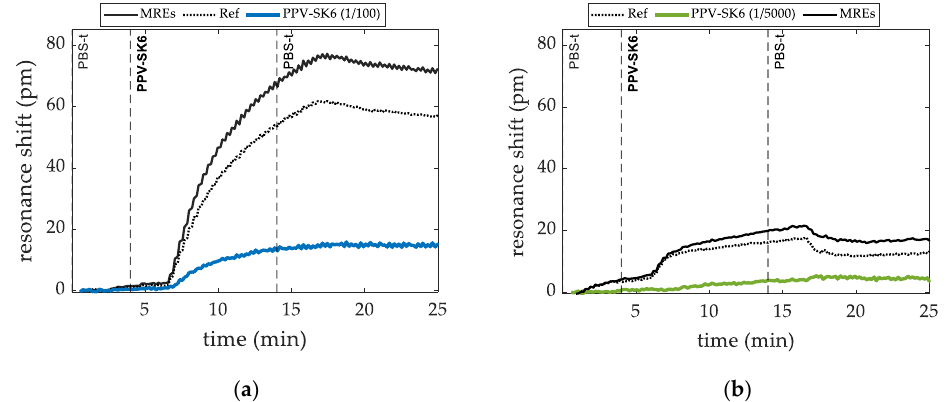
Figure 4. Differences between resonant notch shift obtained from the RRs with MREs immobilized on top of the sensors (black line) and from the references (dotted line) for the detection of PPV at dilutions of PPV at 1/100 ( a ) and at 1/5000 ( b ).